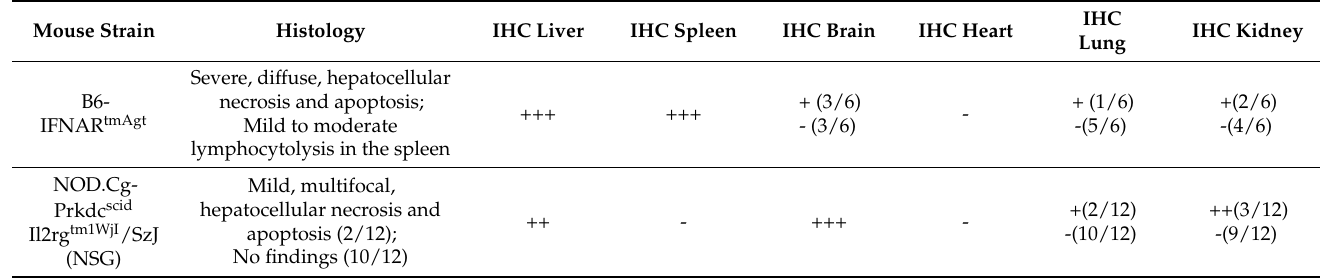
Table 4. Summary of histology and immunohistochemistry results of B6-IFNAR tmAgt and NSG mice.